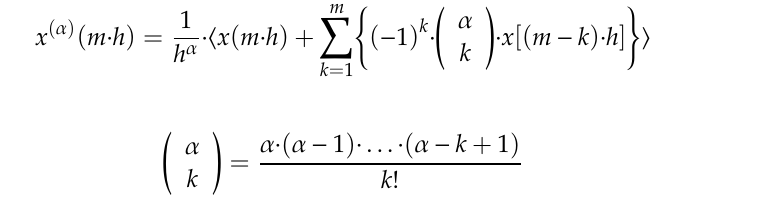
Figure 5. Measurement setup with the dynamometer (on the left) and the studied synchronous generator (on the right).